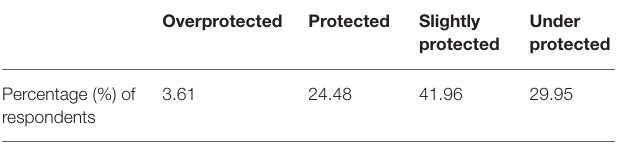
Percentage (%) of respondents